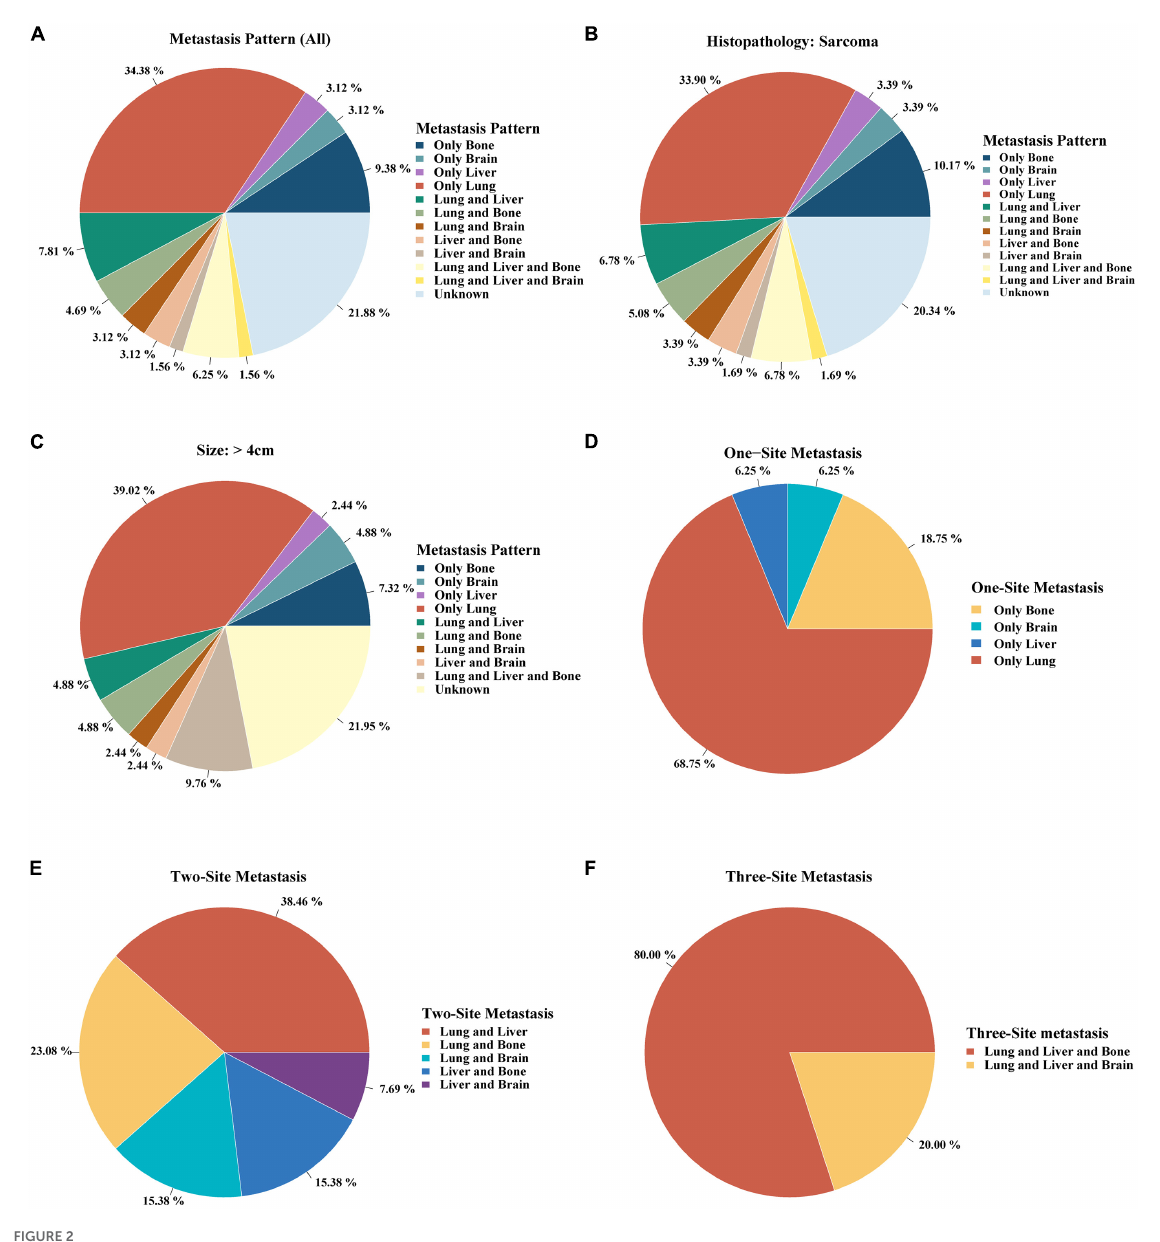
FIGURE2 The proportion of distant metastases in different metastatic patterns.